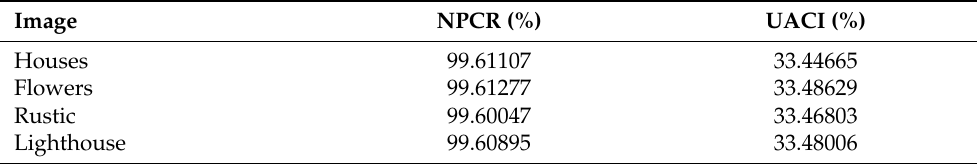
Table 15. NPCR and UACI values for the investigated dataset by changing one bit in the plain image.